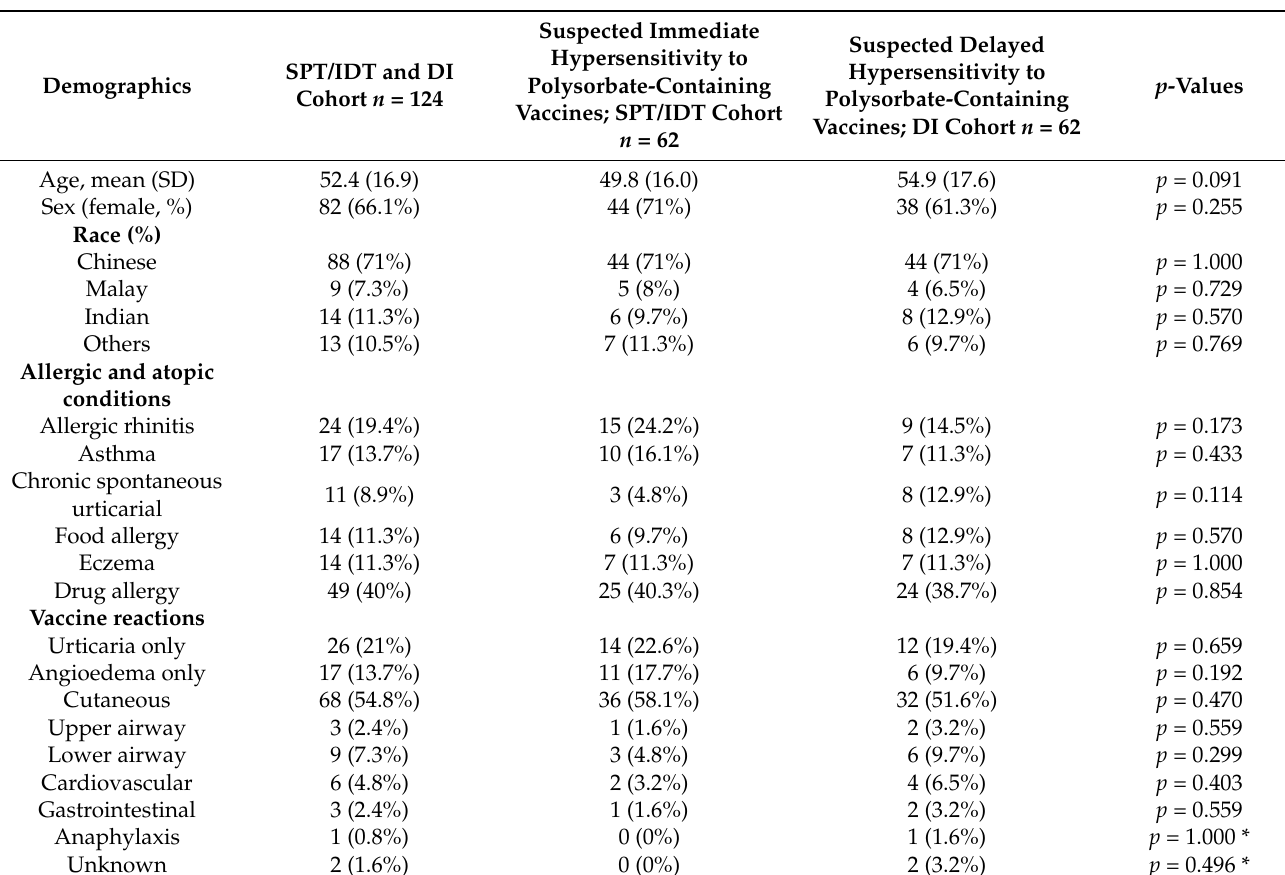
Table 1. Demographic characteristics and reaction details of patients with non-COVID-19 polysorbate- containing vaccine allergies.